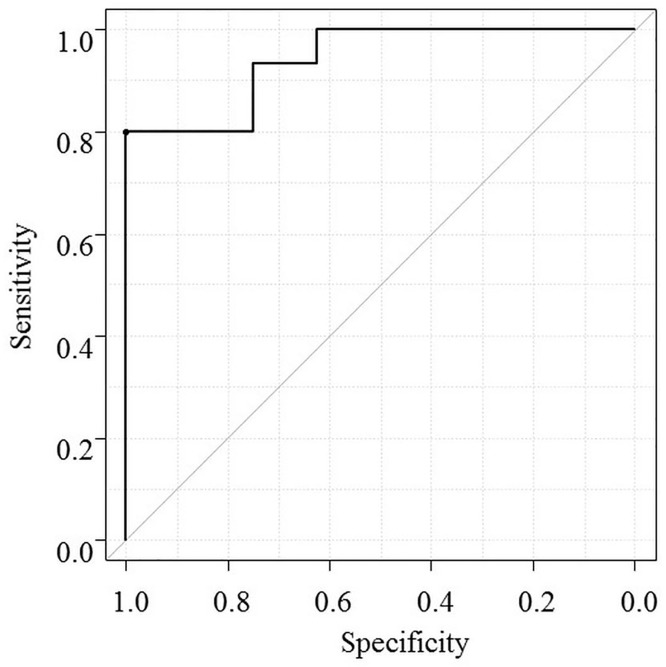
ROC curve analysis of urine Na/K ratio and prediction of total urine Na excretion per day.ROC analysis revealed that urine Na/K ratio was closely associated with urinary Na excretion ≥ 78 mmol/day, with the area under curve of 0.94 (95% CI: 0.85–1.0).